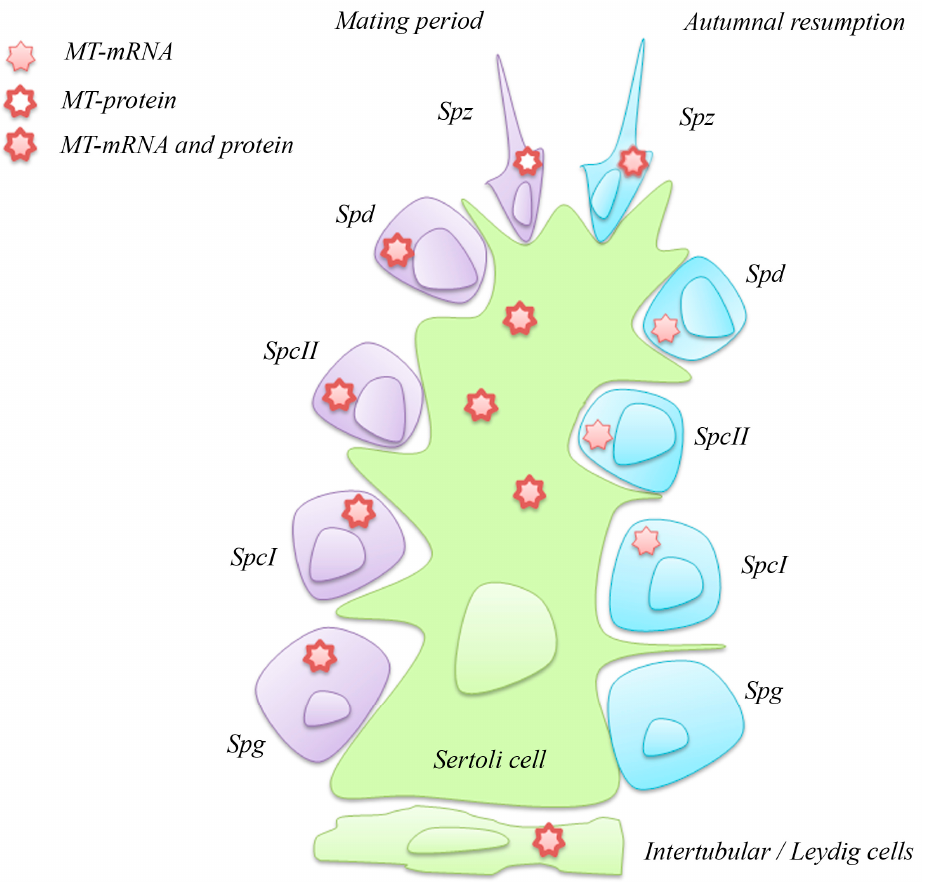
Figure 4. Schematic representation of MT mRNA and protein localisation in P. sicula testis during two stages of reproductive cycle. Spg, spermatogonia; SpcI, primary spermatocytes; SpcII, secondary spermatocytes; Spd, spermatids; Spz, spermatozoa.